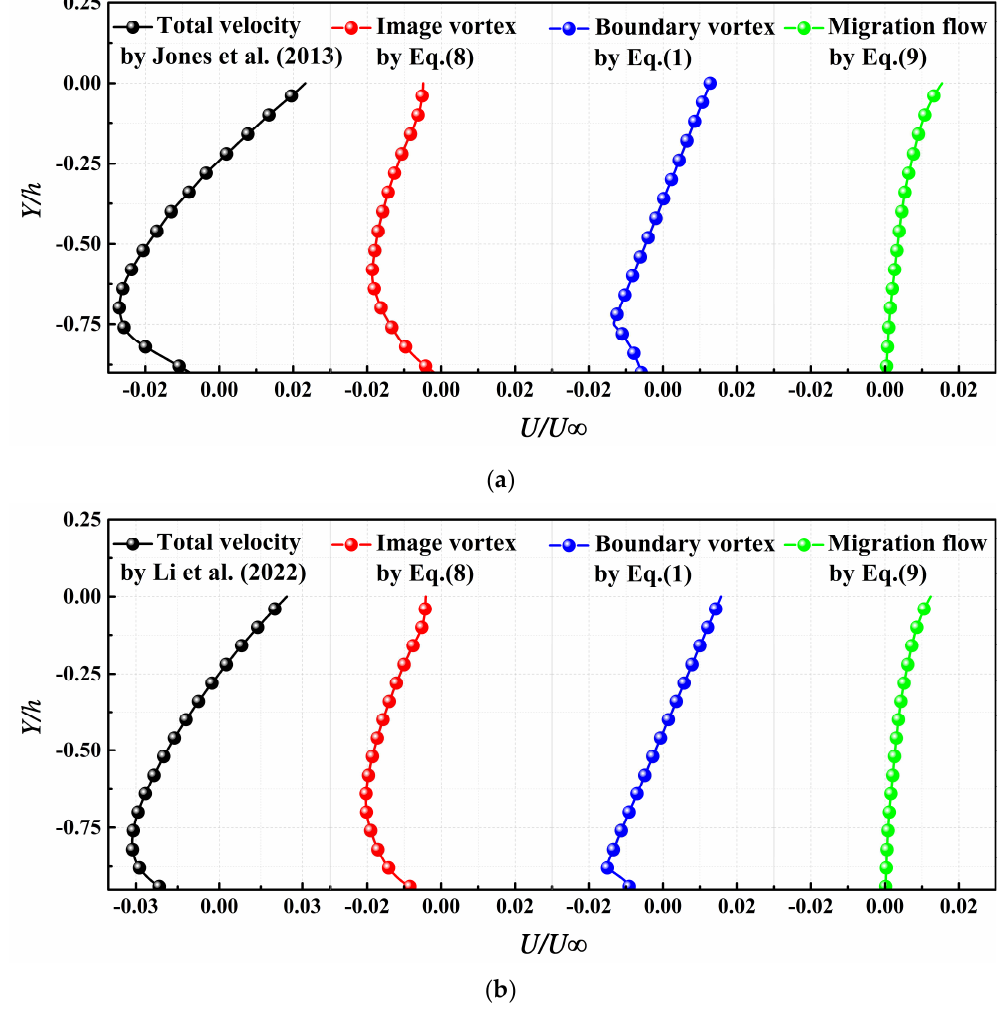
Figure 7. Decomposition of the mainstream velocity profiles in different grooves. ( a ) AR = 1.33, h = 2 mm, and Re h = 750 [34]; ( b ) AR = 2, h = 0.2 mm, and Re h = 68